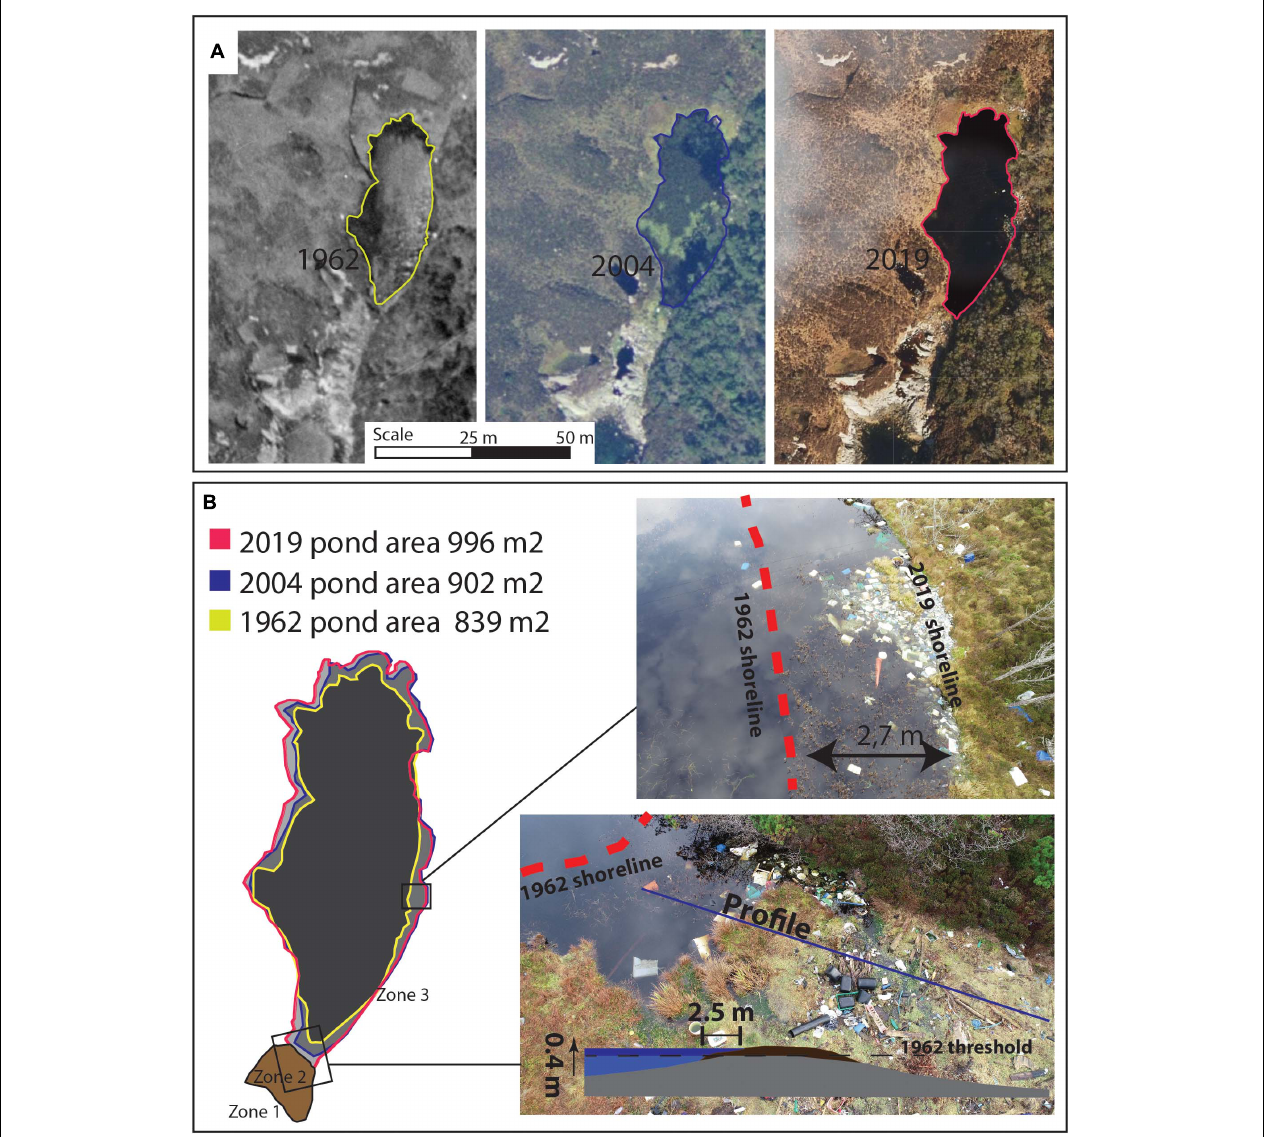
FIGURE 7 | (A) Comparing landscape features from historical images from 1962 and 2004 to current situation in 2019. (B) Shoreline comparison shows a pond increase from 1962 to today. The increase is observed as 2–3 meter horizontal extension? along the eastern and northern shores. At western shores the horizontal increase is less due to steep shore gradient. In Zone 2 where the pond is dammed by the embankment, shoreline has moved toward pond, indicating that the embankment has increased in size since